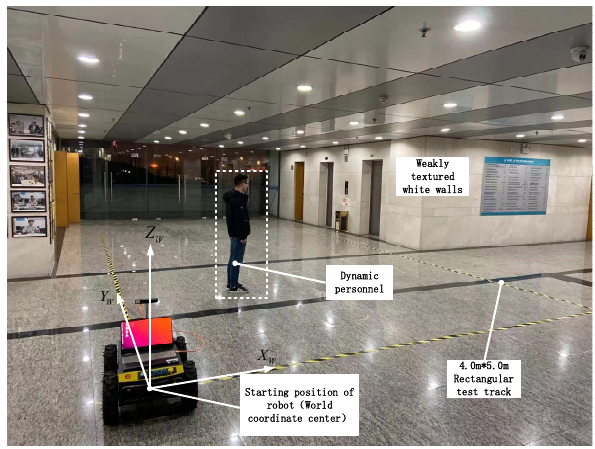
Figure 9. Deployment of the real environment.